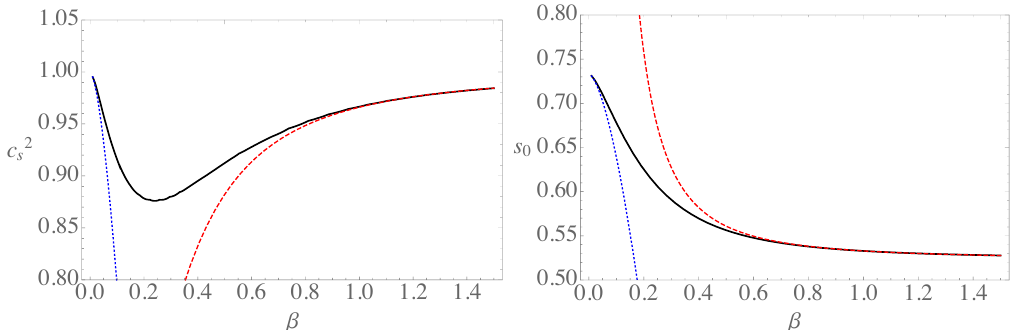
Figure 4: Same as Fig. 3, but for flow from tricritical Ising model deformed by ε (cid:48) to the critical Ising model. Red, dashed lines in this case are the leading correction in the IR due to the T ¯ T deformation around Ising; blue, dotted lines are leading correction in UV from conformal perturbation theory; and black, solid line is numeric result from [ 78 ]